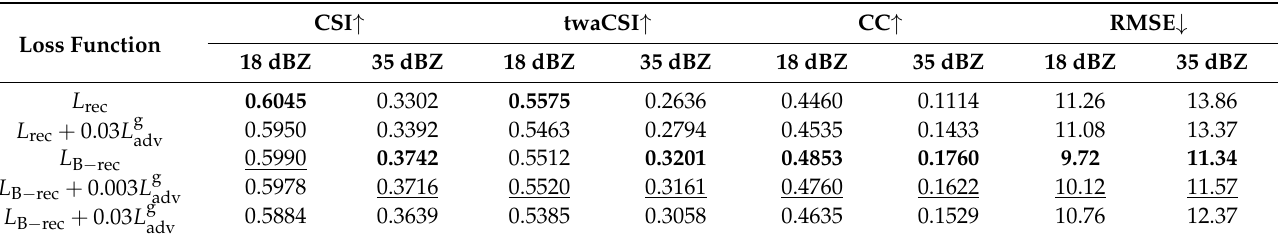
Table 5. Quantitative evaluation of different loss